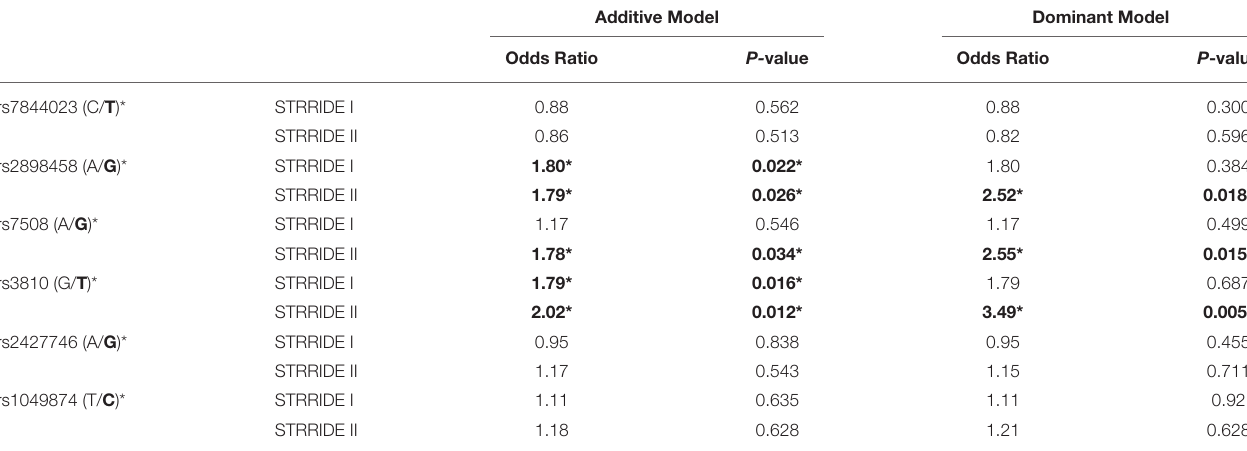
TABLE 3 | Genotype association with risk of failure to complete study, controlling for race, gender, and intervention group. Additive Model Dominant Model Odds Ratio P- value Odds Ratio